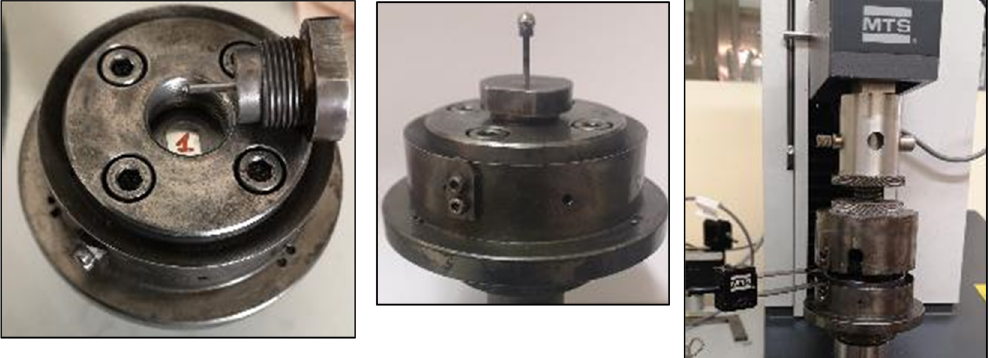
Figure 9. Specimen 1 placed in the SIMUMECAMAT SPT testing device (left). Punch rod (middle). SPT testing machine (right).